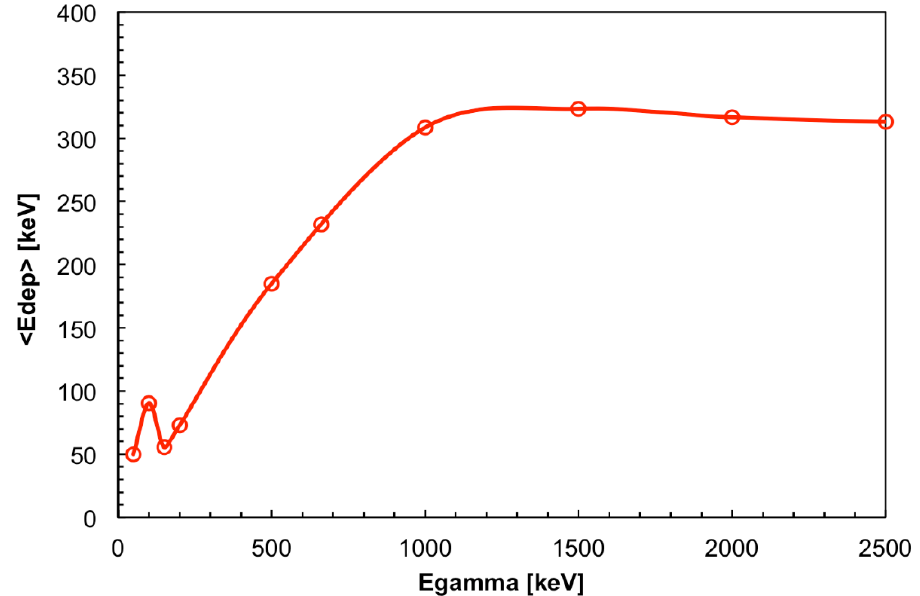
Figure 2. Simulation of the average energy deposited in a 3 mm diameter fiber as a function of the impinging gamma-ray energy (threshold at 50 keV). The lines are spline interpolations.